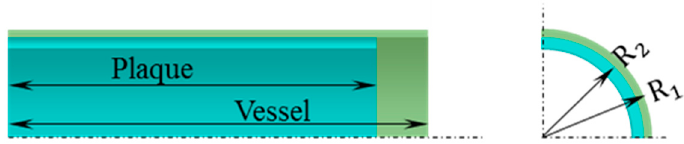
Figure 1. Geometric model of vessel and plaque (one-eighth).